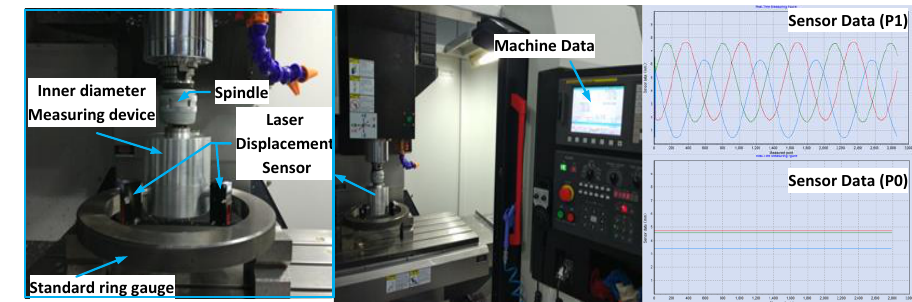
Figure 8. Experiment physical map.